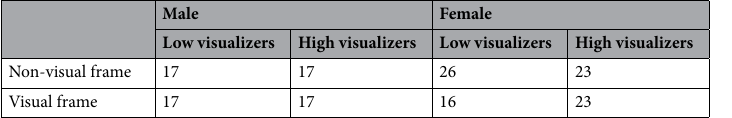
Table 4. Group sizes.